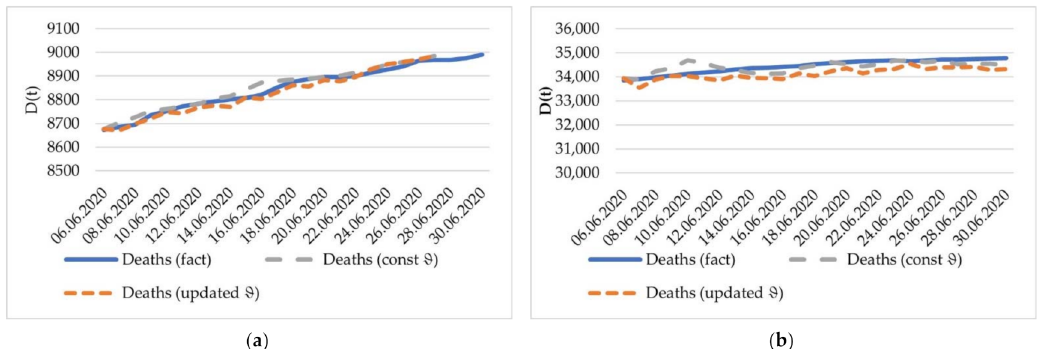
Figure 15. Dynamics of D ( t ) , the actual and calculated trajectories in the interval from 6 June to